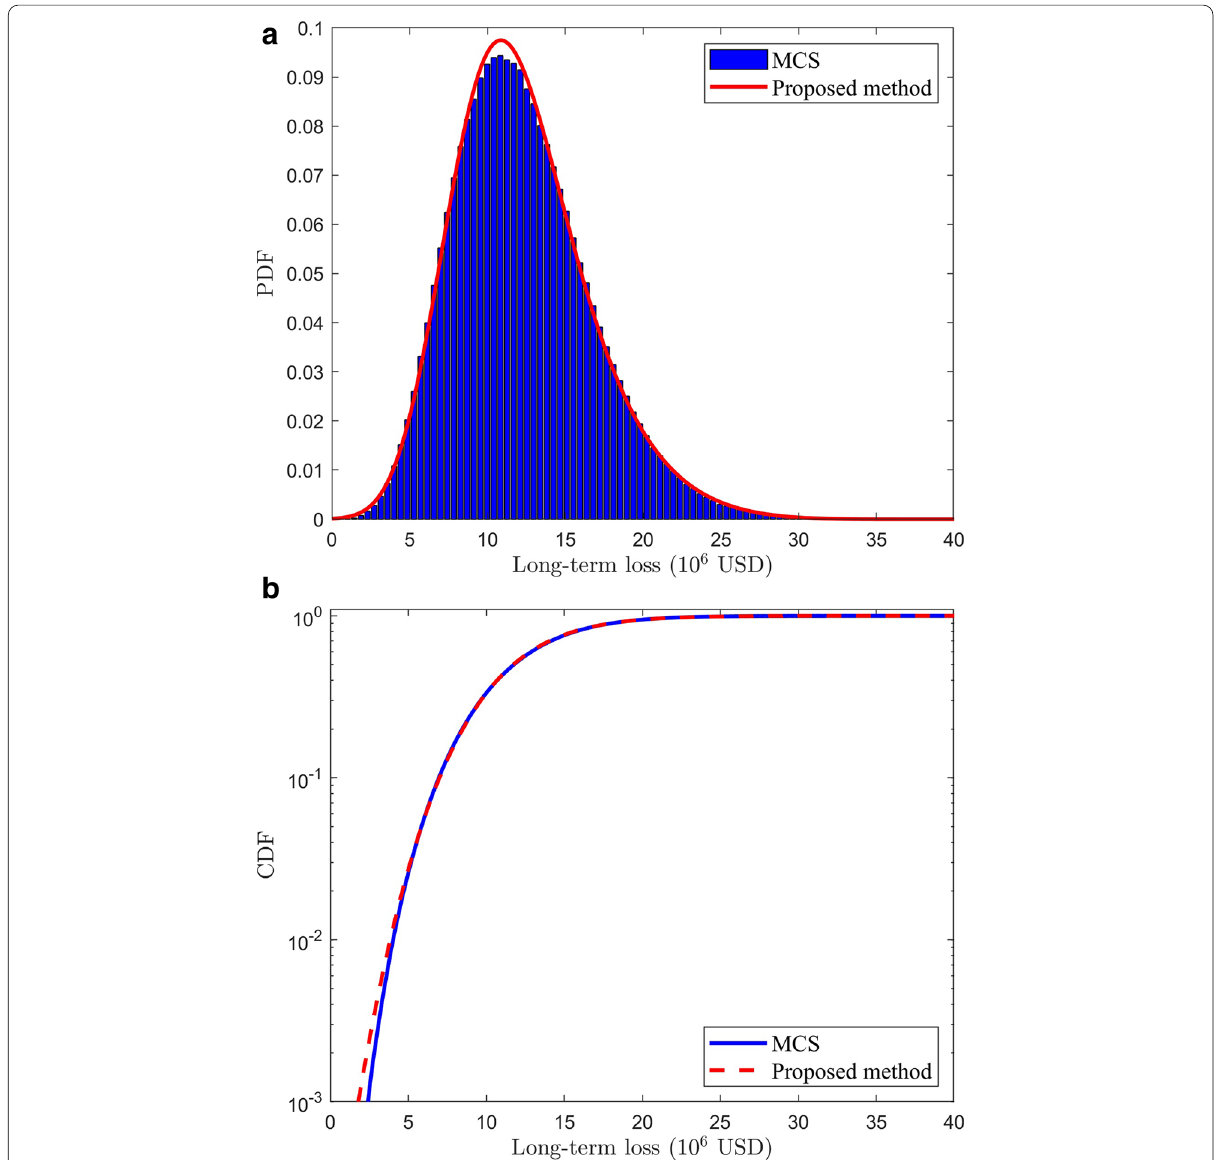
Fig. 3 ( a ) PDF and ( b ) CDF of long-term loss obtained by Monte Carlo simulation and proposed method (75 years, r